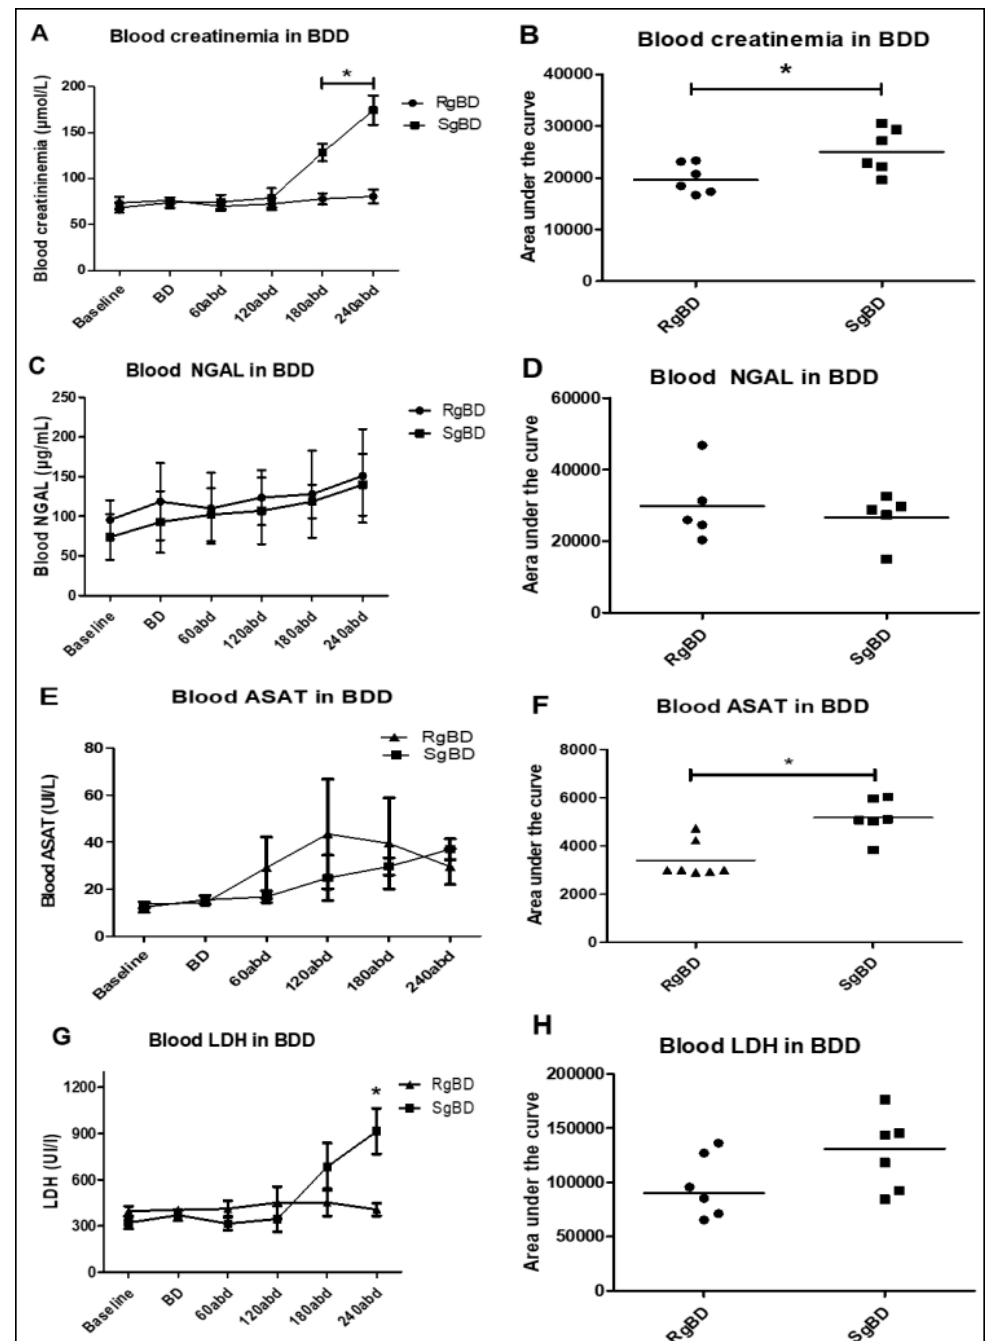
Figure 3 . Donor management: Biological stability of the two groups during reanimation. Evaluation of kidney injury marker evolution during BD donor management after rapid brain death induction (RgBD) or slow brain death induction (SgBD). Blood creatinine ( A - B ), blood NGAL ( C - D ), blood aspartate aminotransferase activity (ASAT) ( E - F ) and blood LDH ( G - H ) concentration blood evolution, investigated at control time (baseline), brain death time ( BD ), and per donor management at 60, 120, 180 and 240 min after brain death (abd; n = 5–6 per group). Kinetic results ( A ), ( C ), ( E ) and ( G ) are expressed as mean ± SD, statistical analysis was performed with a Kruskal–Wallis multiple-comparison Dunn’s test. Areas under the curve ( B , D , F , H ) are expressed in a scatter plot with the median, statistical analysis was performed with a Mann–Whitney test. * p <